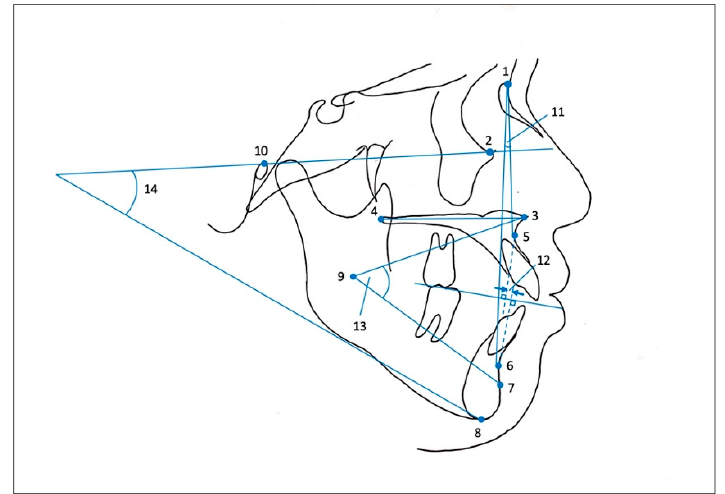
Figure 4. Cephalometric measurements (skeletal pattern). 1: nasion; 2: orbitale; 3: anterior nasal spine (ANS); 4: posterior nasal spine (PNS); 5: point A; 6: point B; 7: PM; 8: menton; 9: xi; 10: porion; 11: ANB angle; 12: Wits appraisal; 13: lower facial height; 14: mandibular plane angle (FMA). Palatal plane angle: the angle between the palatal plane connecting ANS and PNS and the Frankfort plane.